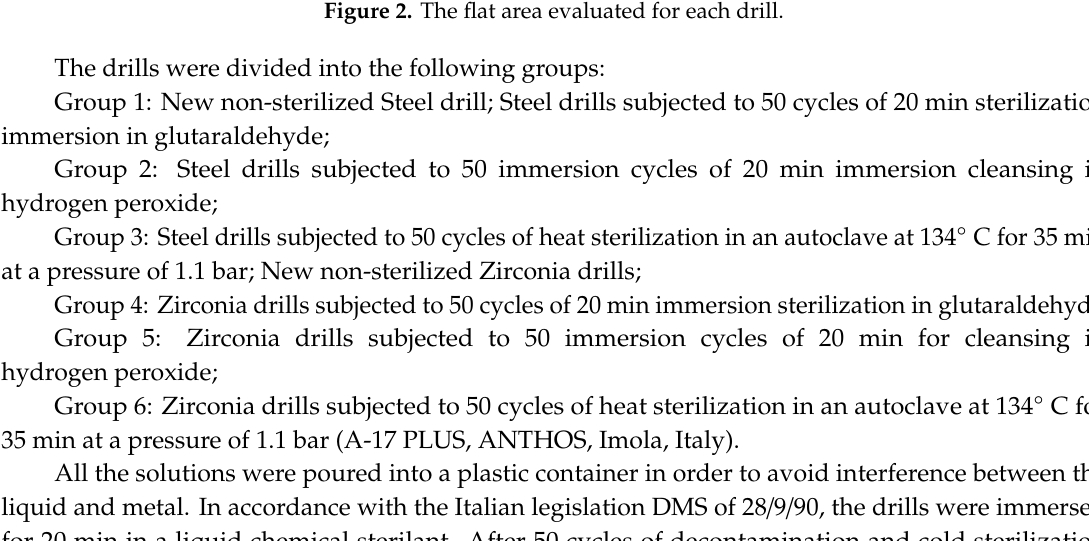
Figure 2. The flat area evaluated for each